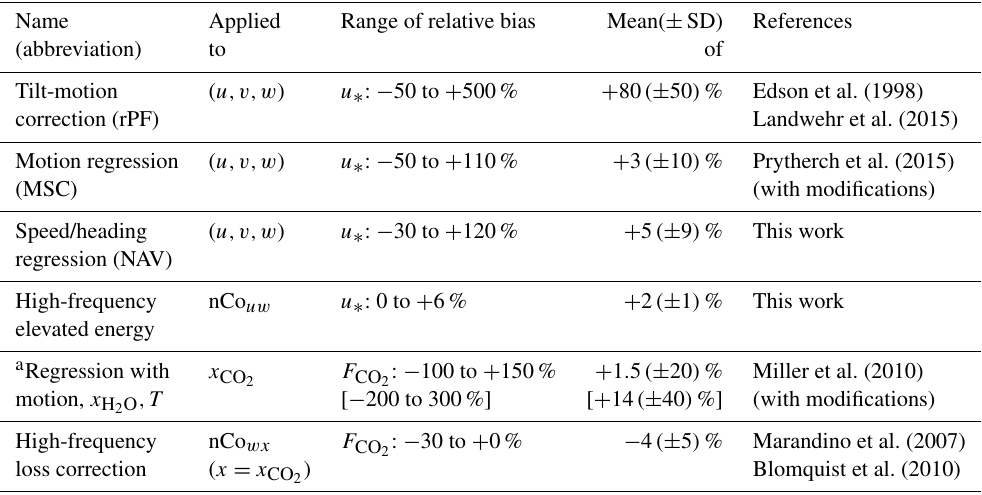
Table 2. Corrections to the EC data listed in the order in which they were applied. The second column indicates to which data the correction is applied. In the third column, the range of bias is given in percent of the corrected value, with negative numbers indicating that the corrected value was underestimated by the uncorrected observation. The mean and standard deviation of the relative corrections for the SOAP data are provided in the fourth column. The fifth column provides applicable